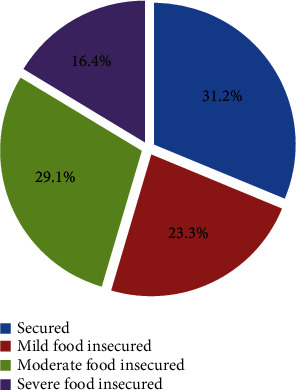
Pie chart illustrating the level of food insecurity among the respondents among people living with HIV/AIDS on follow up at public hospitals of western Ethiopia.